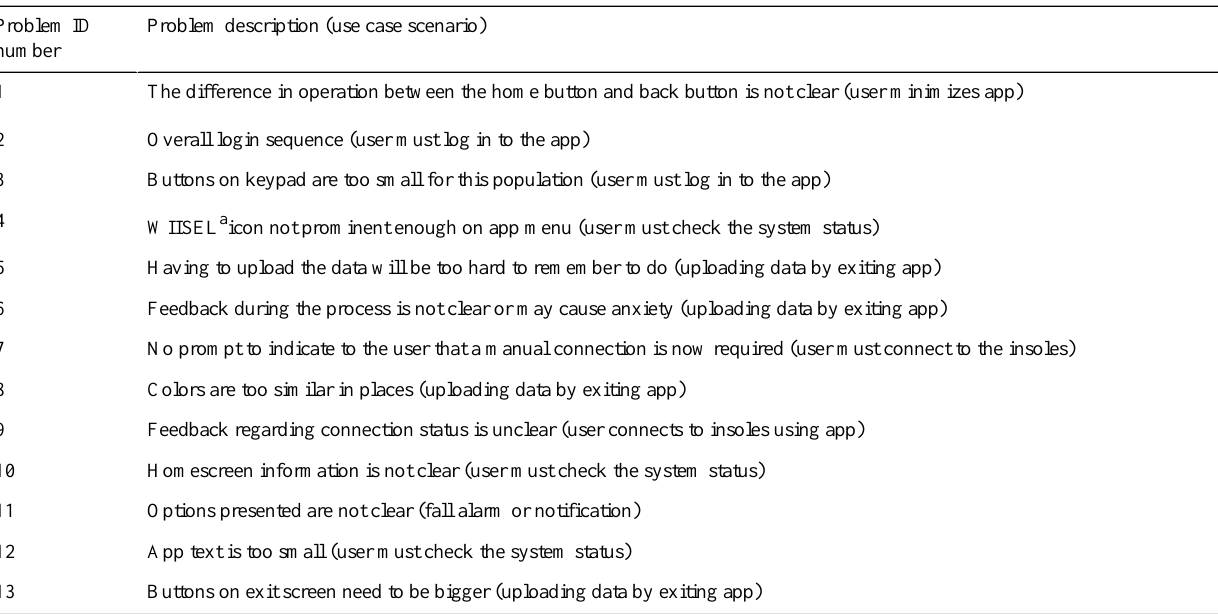
Table 5. List of identified problems and which use case scenario it was identified in. Problem description (use case scenario)Problem